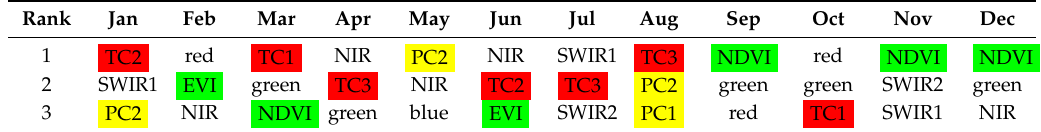
Table 7. Bands’ importance of different months are ranked by the permutation importance value. The vegetation indexes are highlighted in green; the principal components are highlighted in yellow; and bands of the Tasseled Cap (TC) transform are highlighted in red.